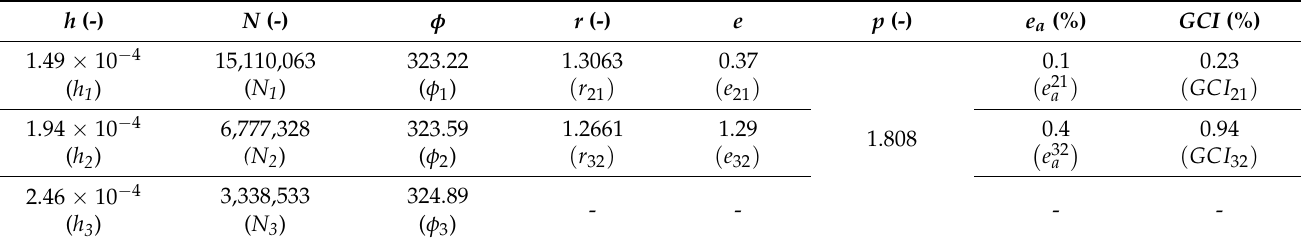
Table 4. Calculation of the grid convergence index.